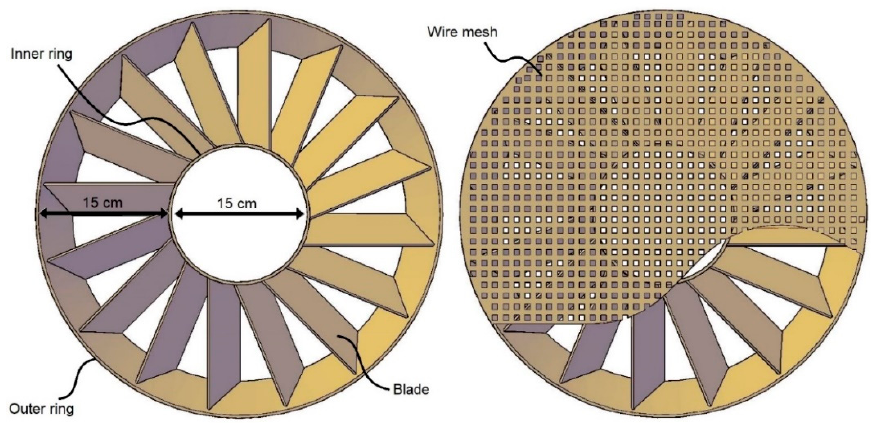
Figure 3. Drawing of an air distributor with and without mesh covering.